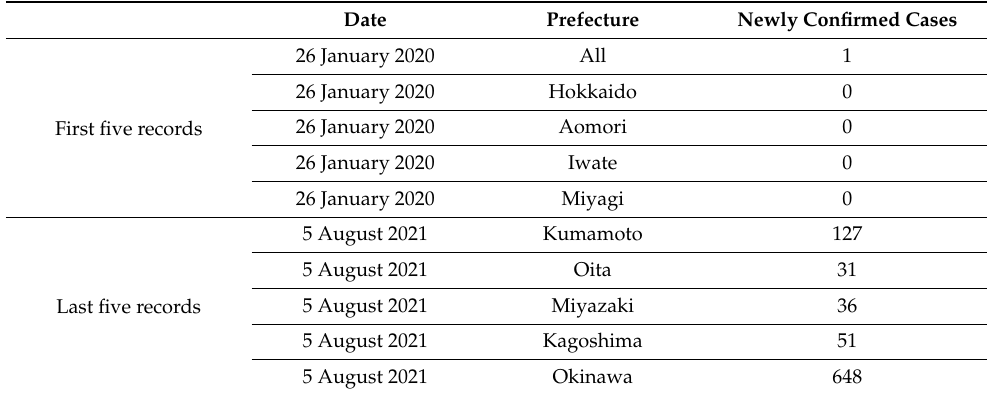
Table 1. Sample of raw